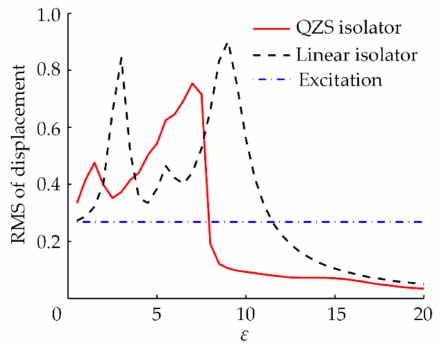
Figure 16. E ff ects of coe ffi cient ε on root mean square (RMS) of displacement.